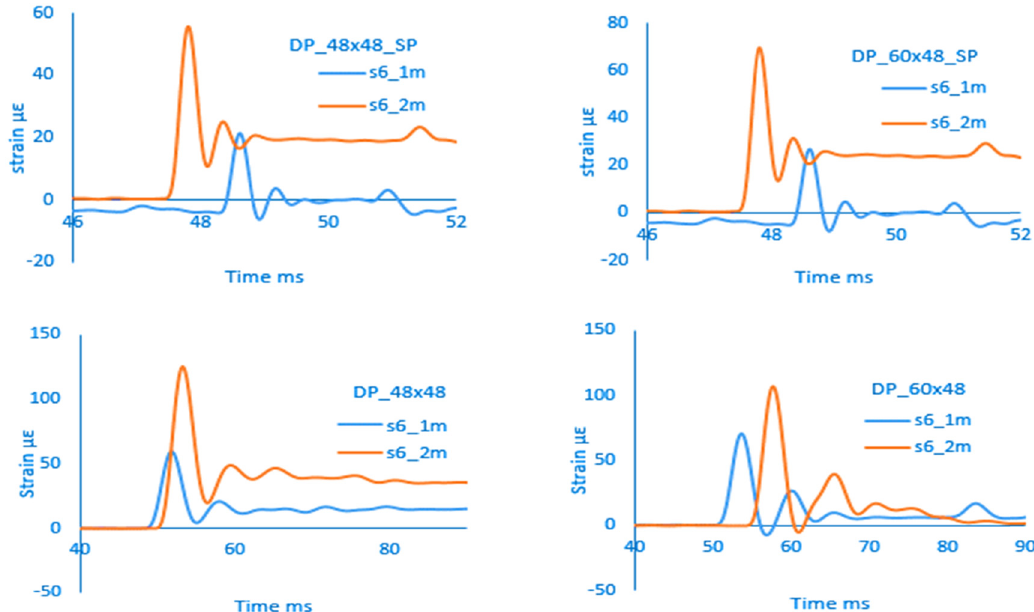
Figure 8: Concrete surface strain – time history at s6 location at di ff erent drop heights.